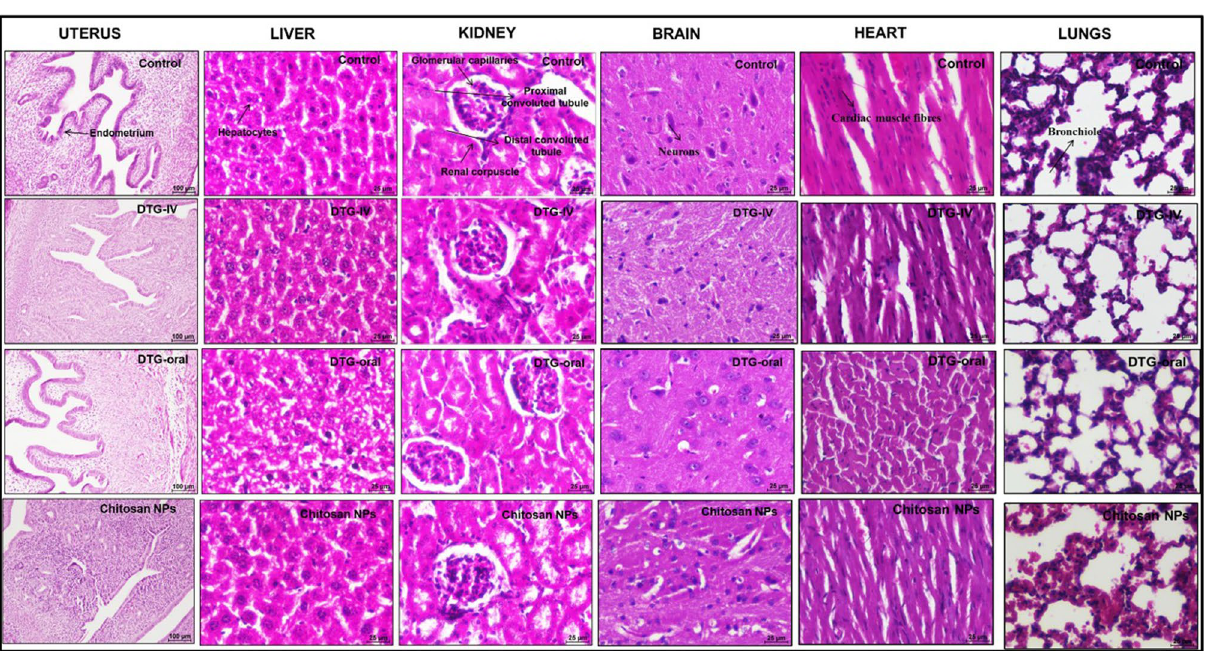
Figure 6. Histomorphological analysis of the organs of treated animals with Chitosan NPs nanoformulation compared with the control